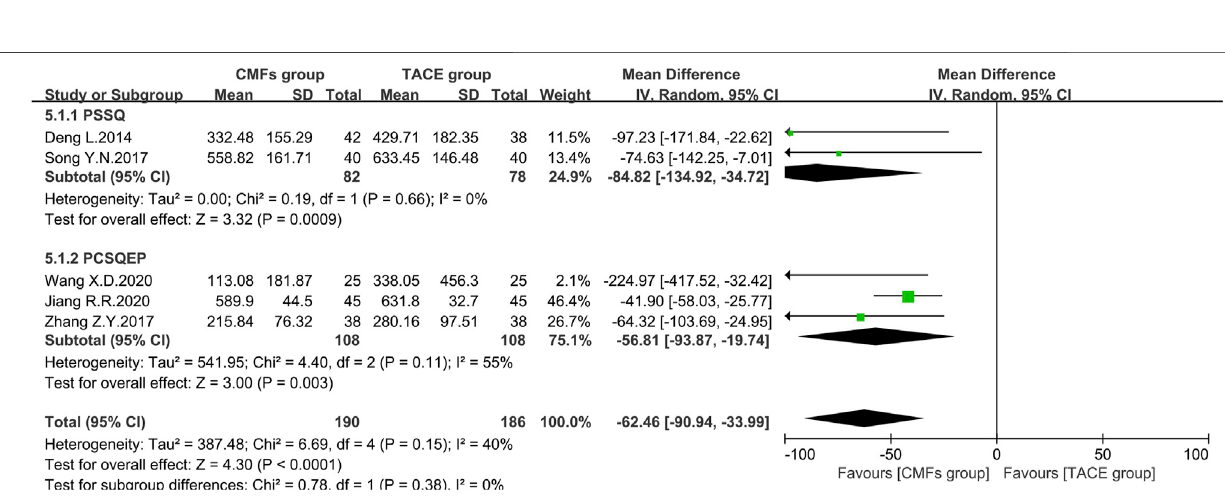
Frontiers in Pharmacology |